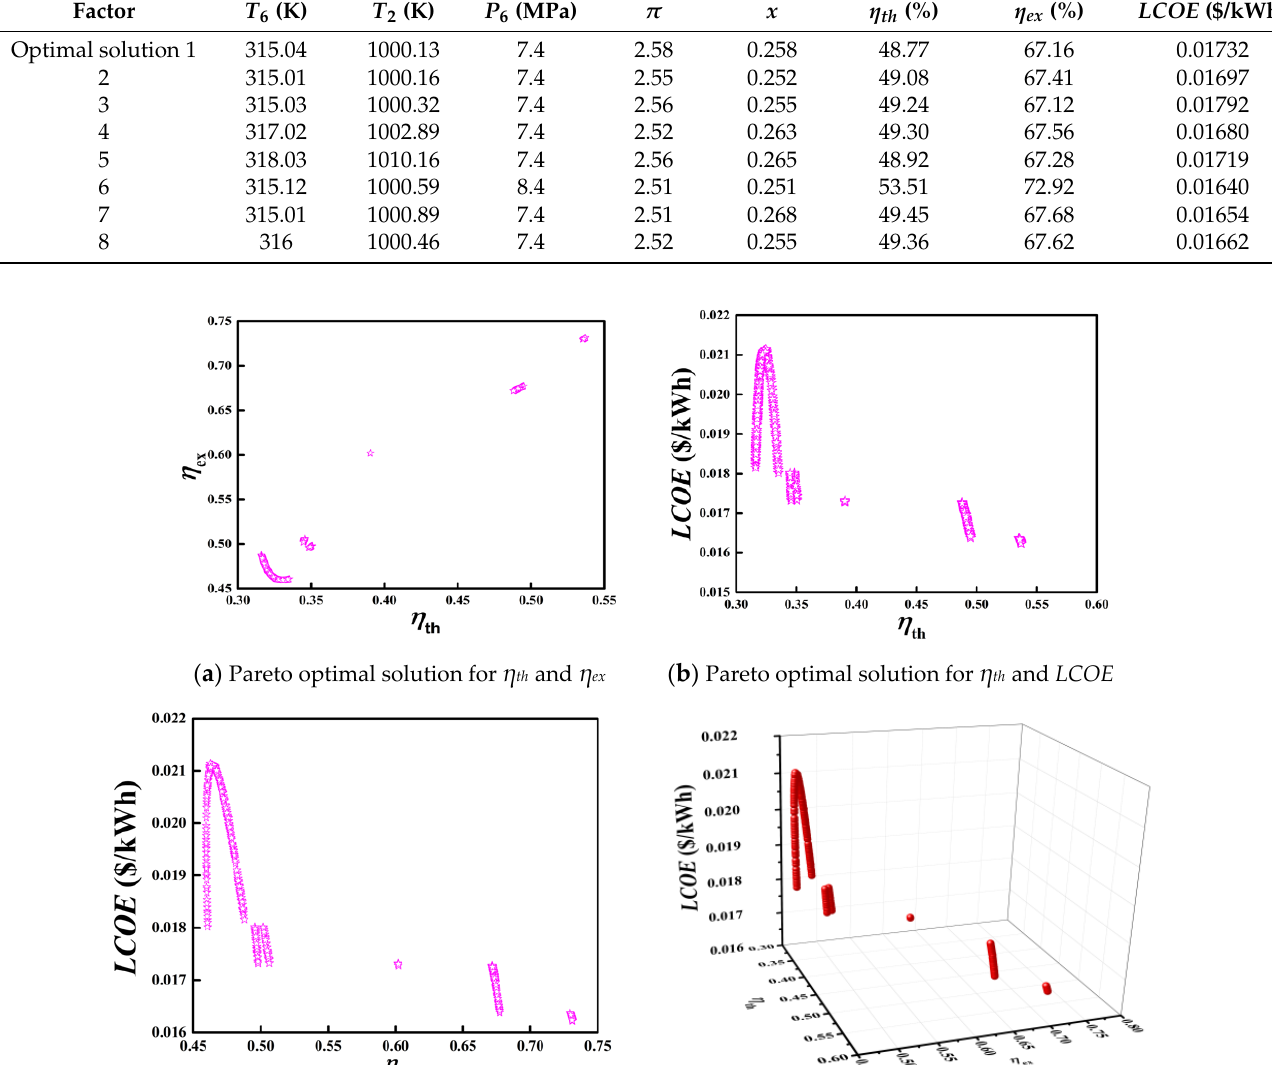
tively. Figure 14d considers the Pareto solution of three objectives: η th , η ex , and LCOE . In